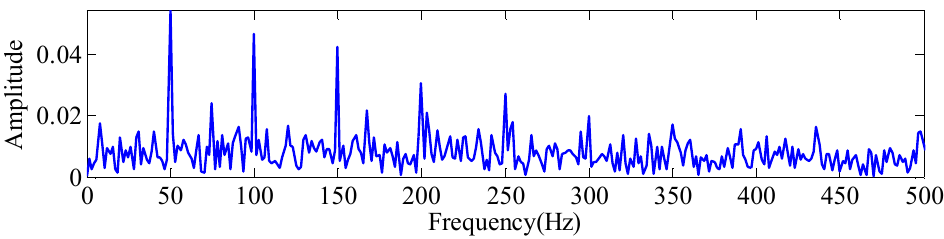
Figure 16. Noise-reducing envelope spectrum diagram of the signal segments selected by this algo- rithm.